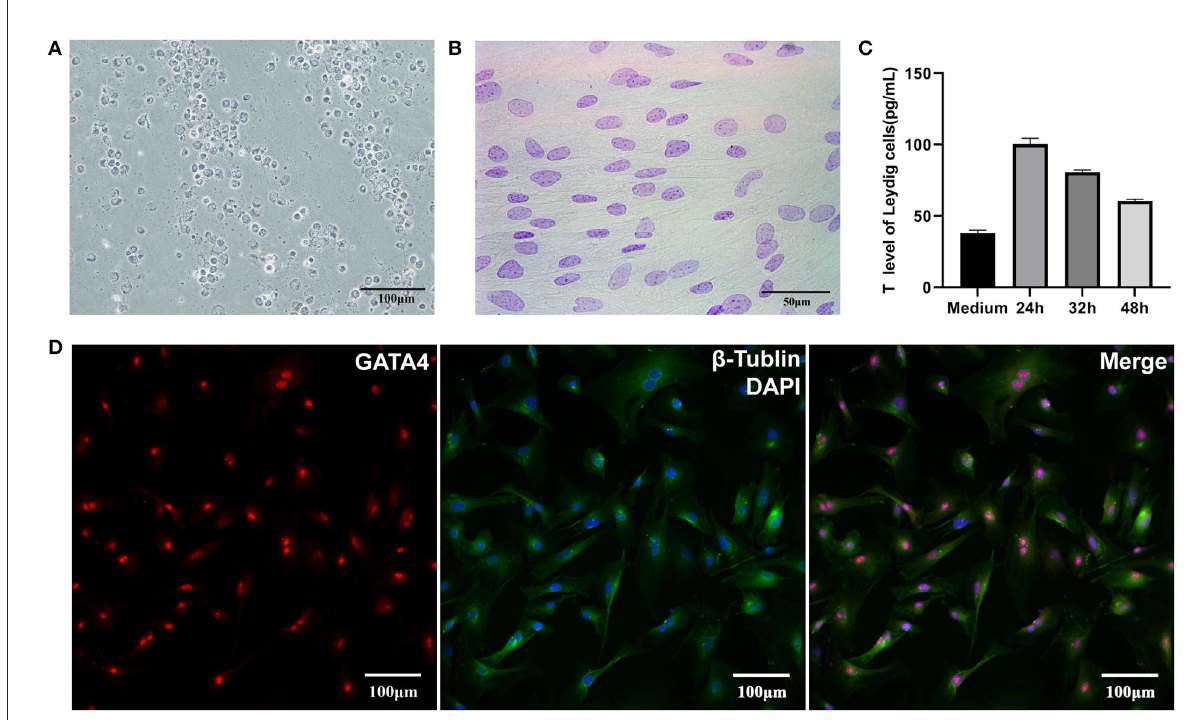
FIGURE1 Identification of LCs and SCs. (A) 3 β -HSD stained LCs, bar is 100 µ m. (B) Feulgen-stained SCs, bar is 50 µ m. (C) Testosterone secretion of LCs in vitro . (D) . GATA4 immunofluorescence stain of SCs, bar is 100 µ m.